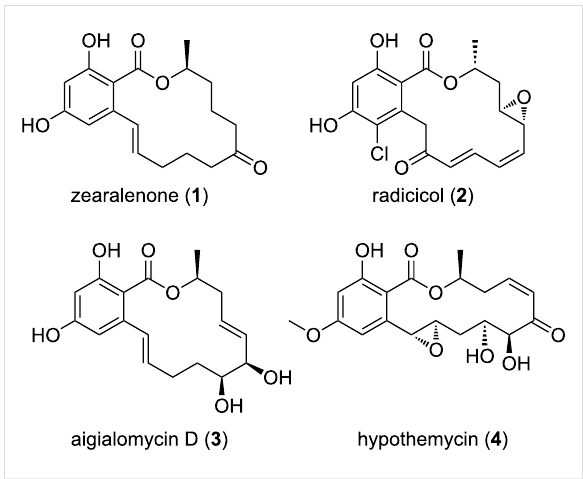
Figure 1: Structure of selected RAL type fungal secondary metabo- lites.